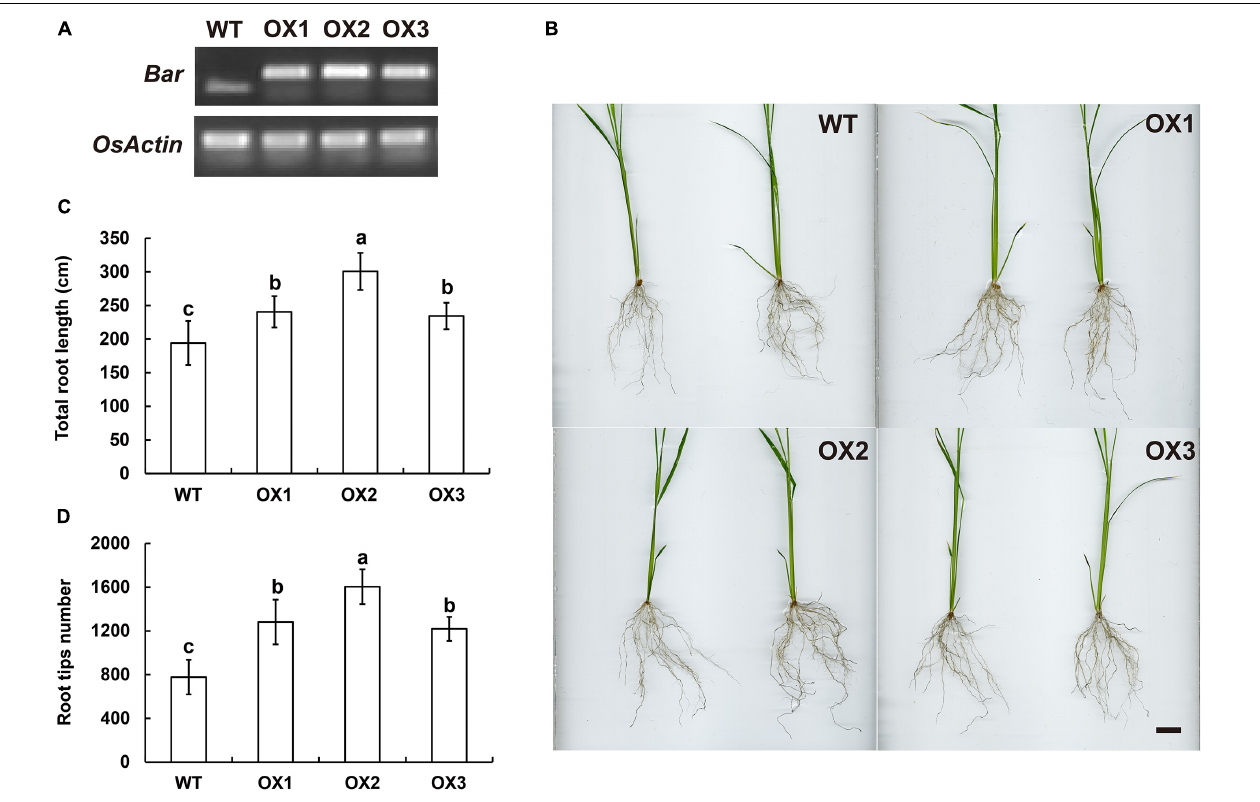
FIGURE 5 | Ectopic expression of EoSINAT5 in “Nipponbare” rice. (A) RT-PCR analyses of T3-overexpressing EoSINAT5 transgenic rice lines. The reference gene is OsActin . The resistance marker gene is Bar . (B) Root phenotypes of WT and EoSINAT5- overexpressing transgenic plants. Scale bar represents 2 cm. (C) Total root length of WT and EoSINAT5 -overexpressing transgenic plants. (D) Root tip numbers of WT and EoSINAT5 -overexpressing transgenic plants. Letters above bars indicate significant differences between the respective values ( p < 0 .